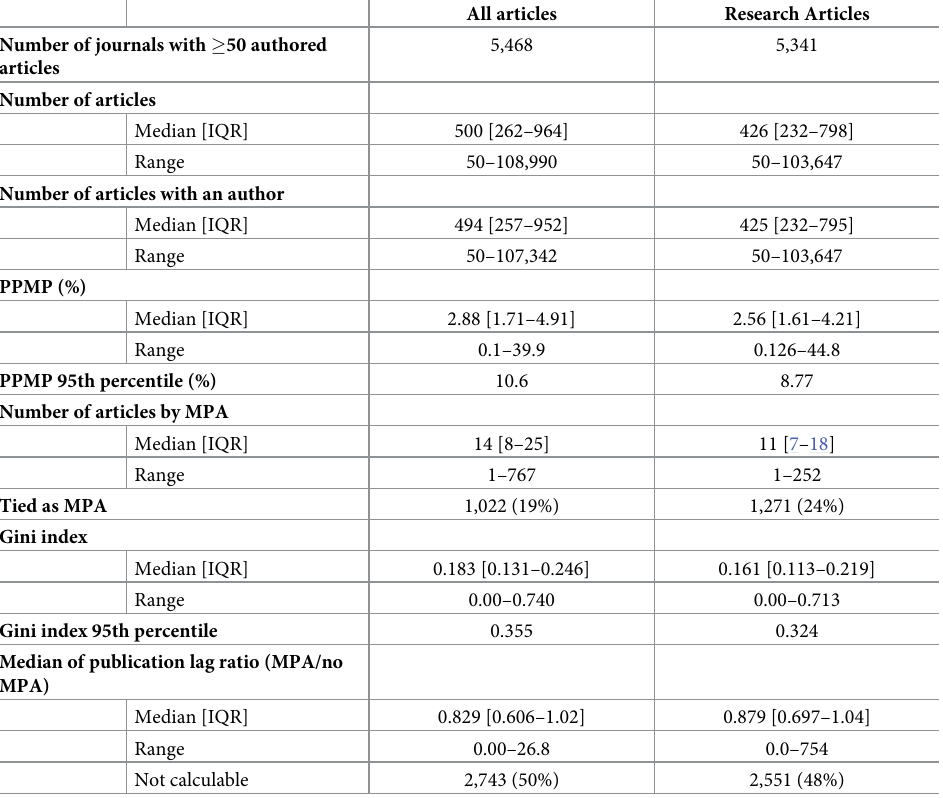
Table 1. Main characteristics of all journals in the United States NLM catalog having at least one Broad Subject Term and having published at least 50 authored articles between 2015 and